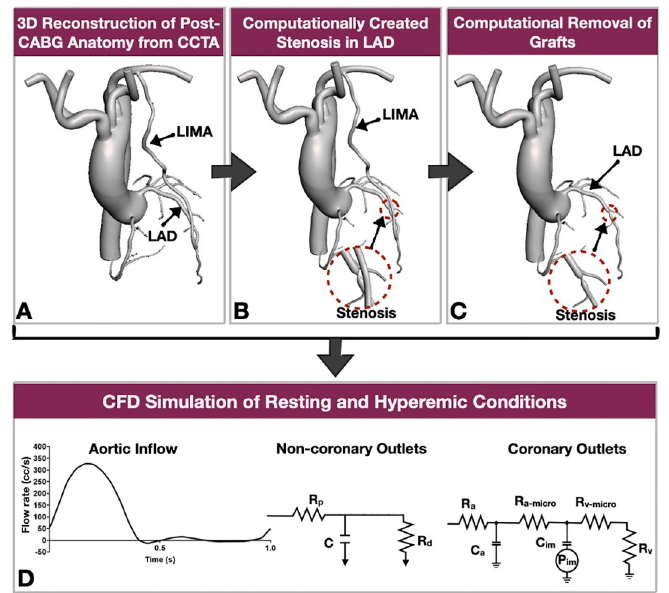
Fig 2. Illustration of the methodologies employed in Aim 2. A . The post-CABG anatomy (coronary arteries, aorta and grafts) were 3D reconstructed from CCTA, B . In the grafted LAD (proximal to the LIMA anastomosis), we computationally created stenosis of varying severity (magnified in insert), C . All the grafts were computationally removed to create the pre-CABG anatomy, D. Computational fluid dynamics were performed in pre- and post-CABG anatomies (LIMA: left internal mammary artery, CCTA: coronary computed tomography angiography, LAD: left anterior descending artery, LIMA: left internal mammary artery, R p : proximal vessels resistance, R d : distal vessels resistance, C: capacitance, R a : coronary arterial resistance, R a-micro : coronary venous resistance, C a : Coronary arterial compliance, C im : intramyocardial compliance, P im : intramyocardial